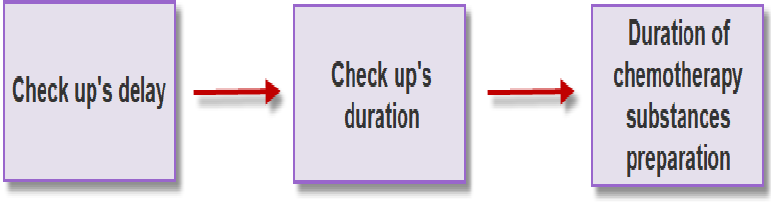
Figure 2. Subsequent stages in the circuit of oncology patients after the theoretical instant of the appointment with the oncologist and preceding the moment when their treatment